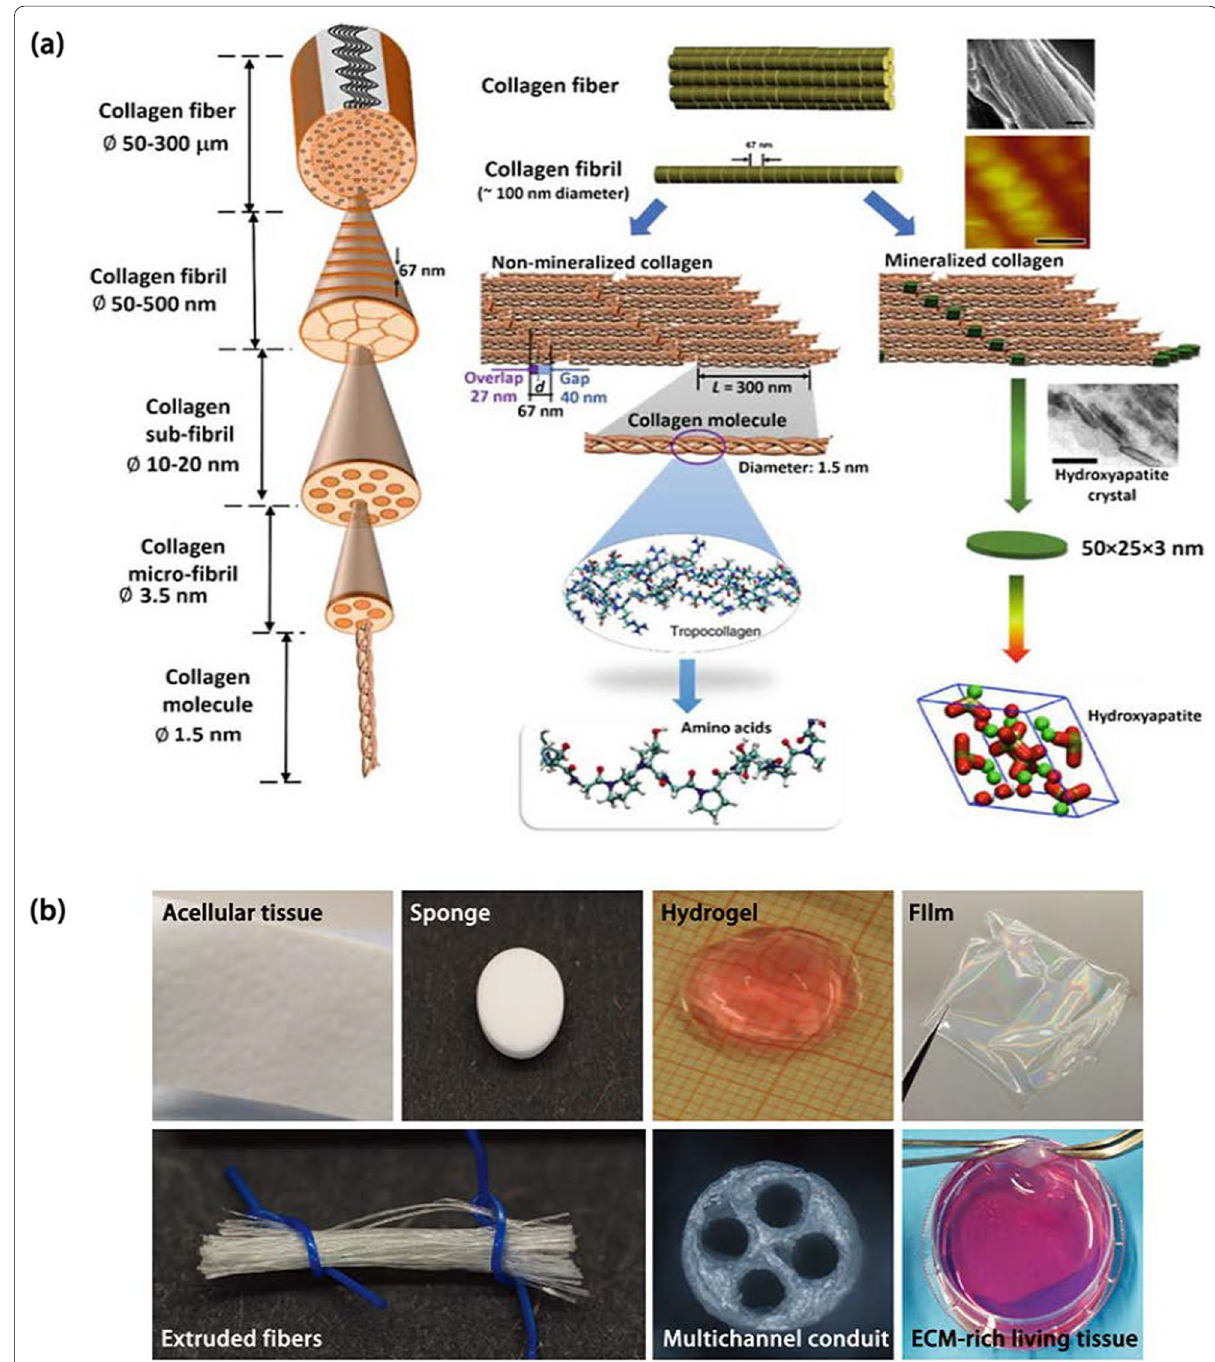
Fig. 2 a Hierarchical structure of collagen fibers from nanoscale to micrometer scale. (Adapted from ref. [54], copyright 2021, with permission from Springer Nature.) b Various forms of collagen-based biomaterials. (Adapted from ref. [62], copyright 2019, with permission from